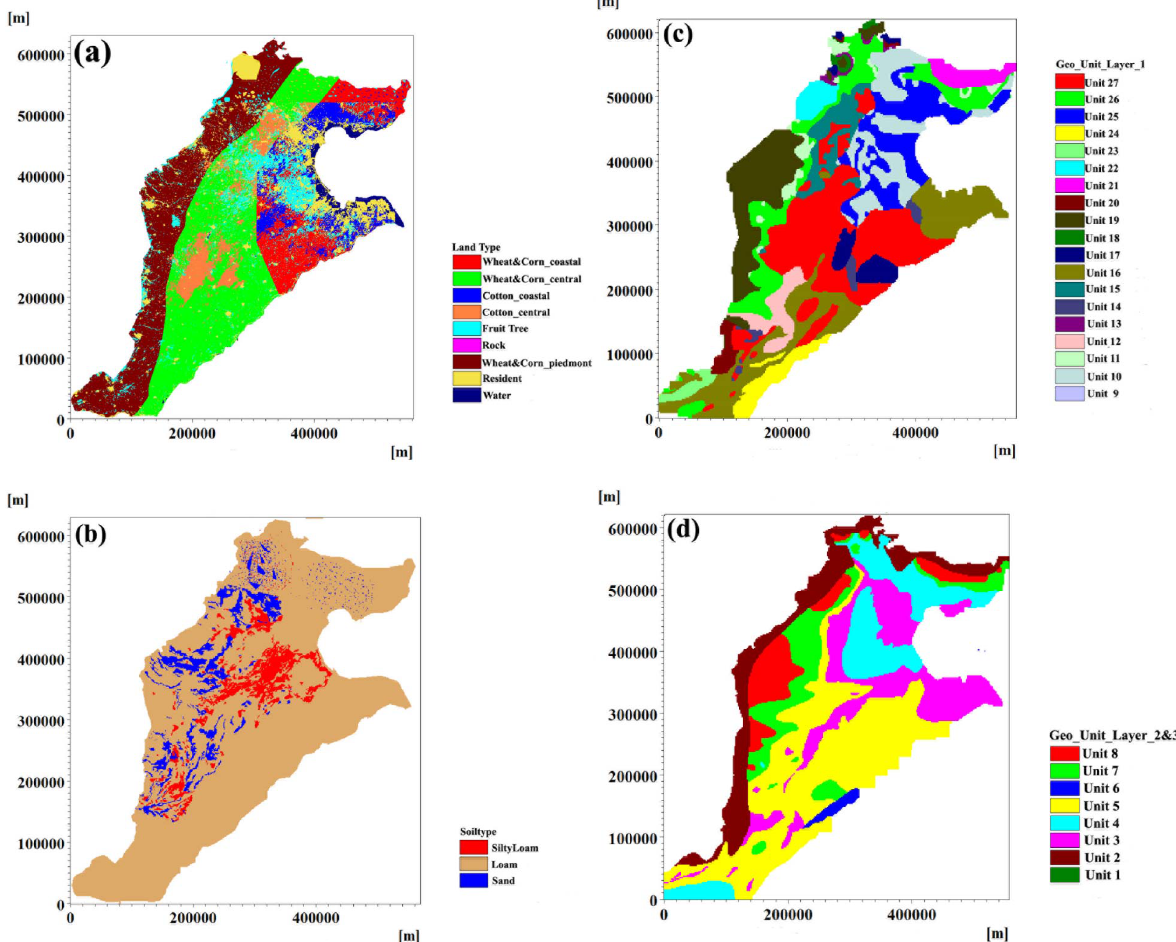
Fig. 2. (a) Land use types after Shu’s model (2010); (b) soil types; (c) hydrogeological units of model layer 1 after the groundwater model of Cao et al. (2013); (d) hydrogeological units of model layers 2 and 3 after the groundwater model of Cao et al.